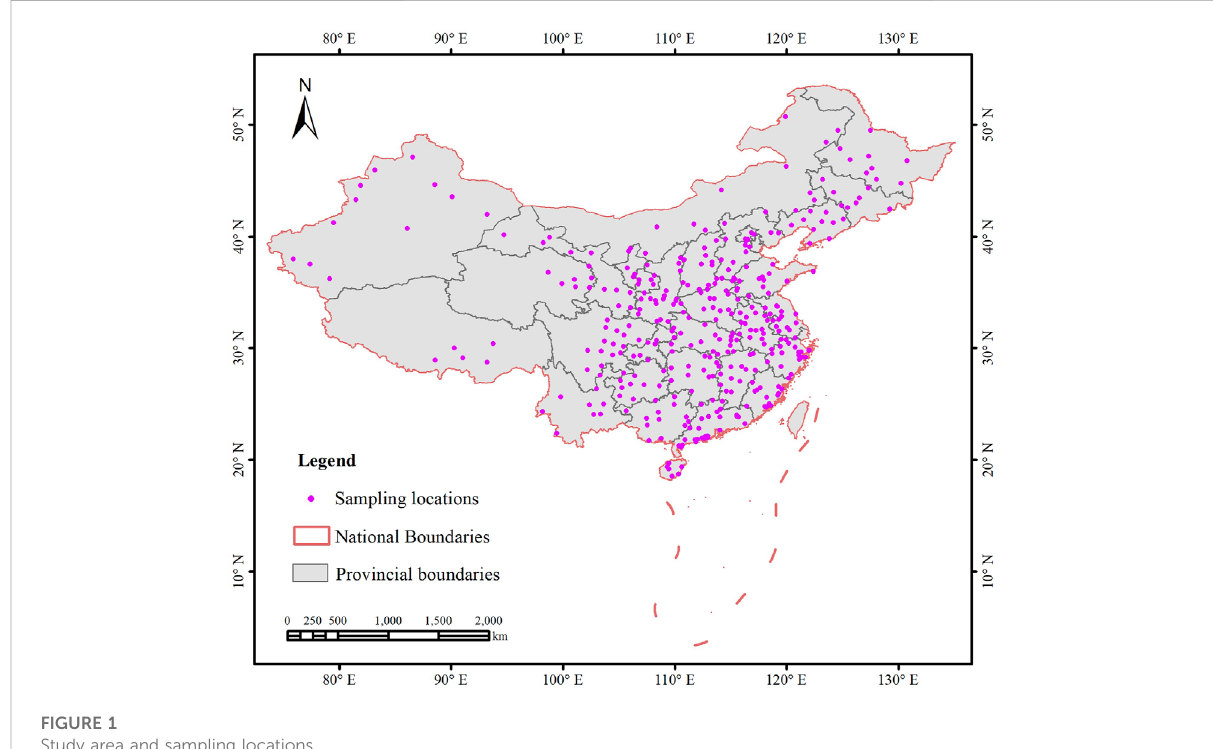
FIGURE 1 Study area and sampling